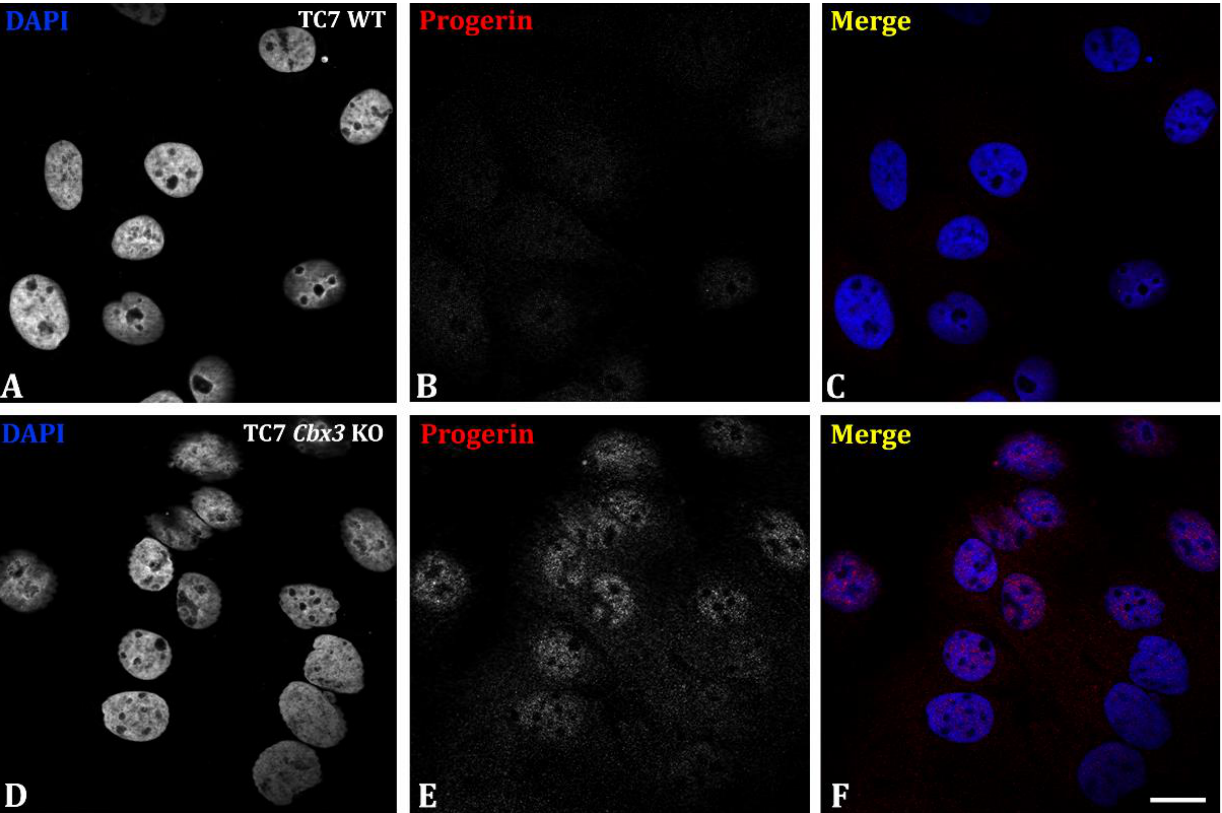
Figure 2 . Analysis of progerin production upon depletion of HP1γ in TC7 cells. ( A – F ) Immunofluorescence study provides evidence for a detection of progerin in the nucleus of TC7 Cbx3 KO cells ( D – F ) but not in TC7 WT ( A – C ). Images are representative of n = 5 clones (generated by 1 sgRNA) per condition, Scale bar: 25 µm.